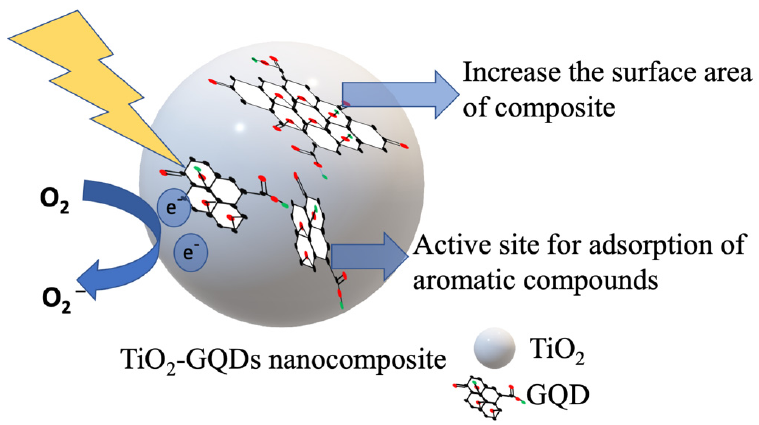
Figure 24. Enhancement of surface area of TiO 2 due to GQD